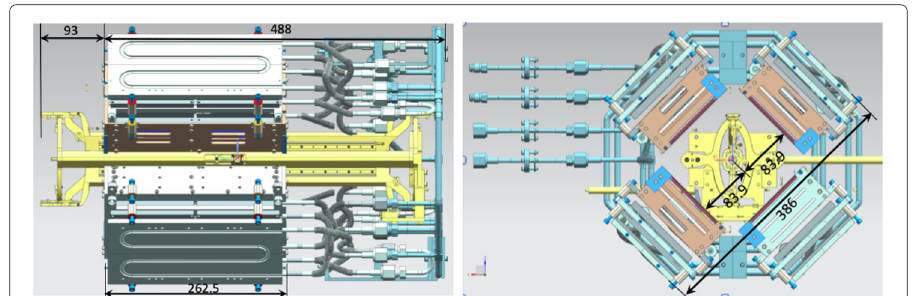
Fig. 12 Side and front views of the PAX detector. The blue connections show the pipes of the cooling circuits; the aluminum box containing the sensors are shown in brown; the storage cell and its support structure are in